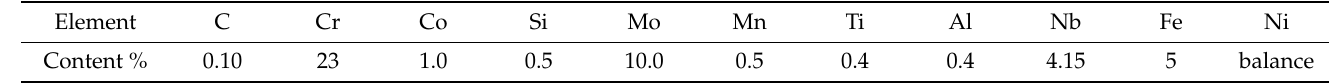
Table 1. Chemical compositions of Inconel 625